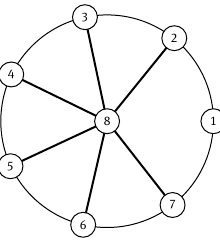
Figure 2.1: The graph W (7, 6) with a (2, 6) -regular set S = { 1, 2, 3, 4, 5, 6, 7 } .